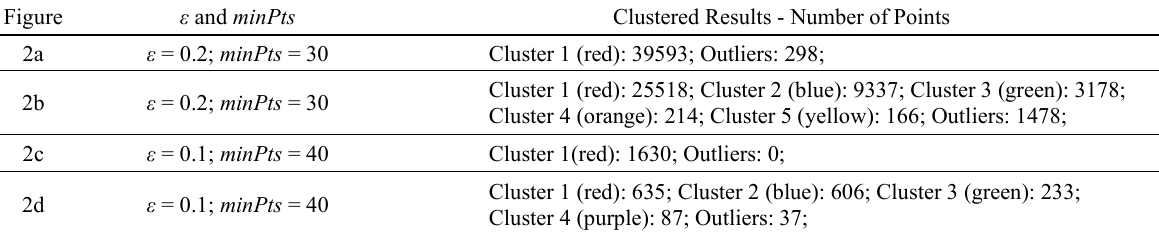
Table 1. Clustering parameters and clustered